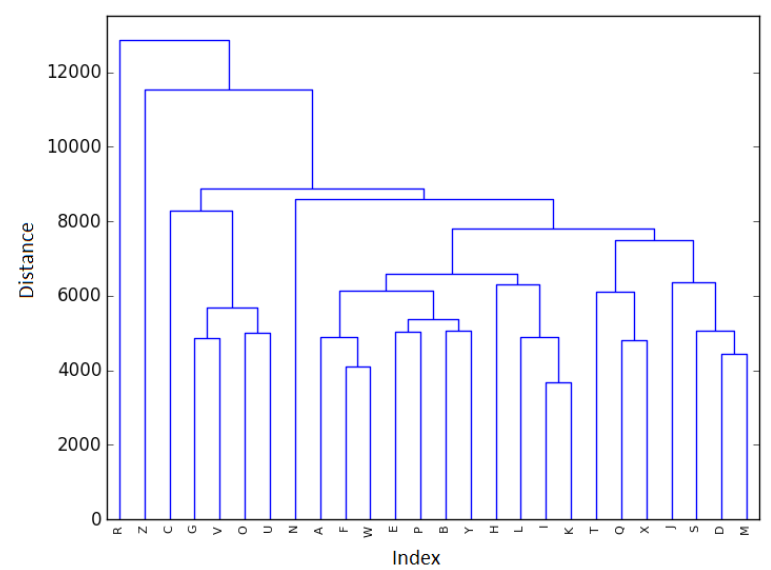
Figure 1. Example dendrogram from 26 data